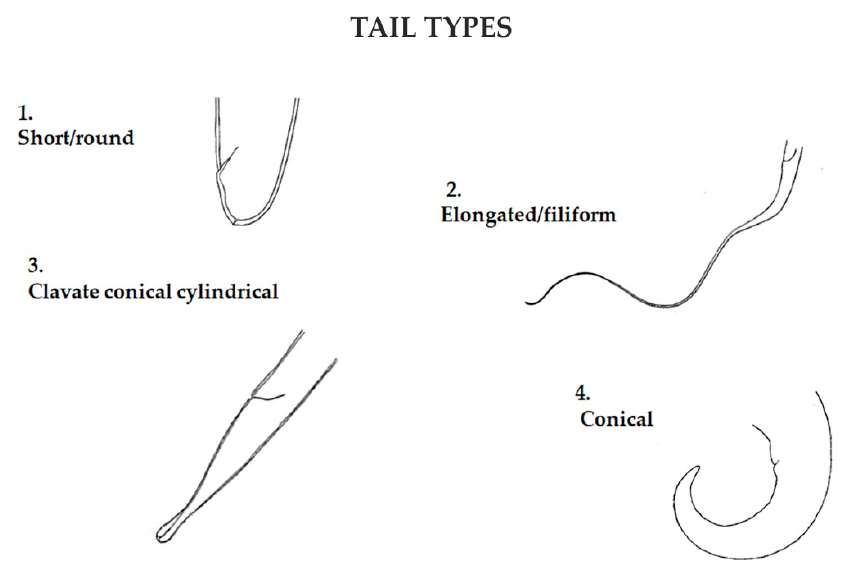
Figure 5. Tail shape has an important role in nematode locomotion, feeding, and reproduction. Four categories were designed: short/round; elongated/filiform; conical; and clavate/conical-cylindrical.